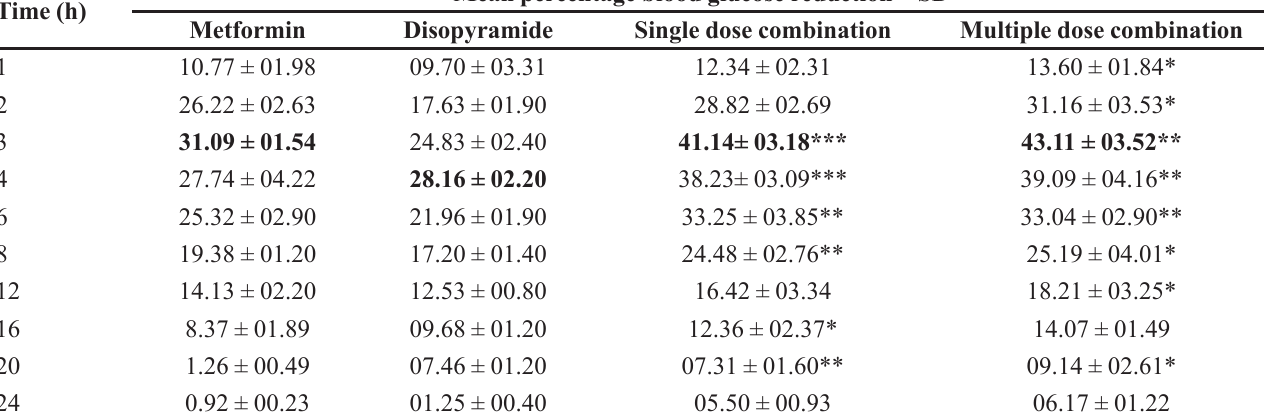
TABLE IV- Percentage blood glucose reduction after oral administration of metformin 70 mg/1.5 kg body weight, disopyramide 14 mg/1.5 kg body weight, disopyramide single dose study and multiple dose study in normal rabbits (n=6)